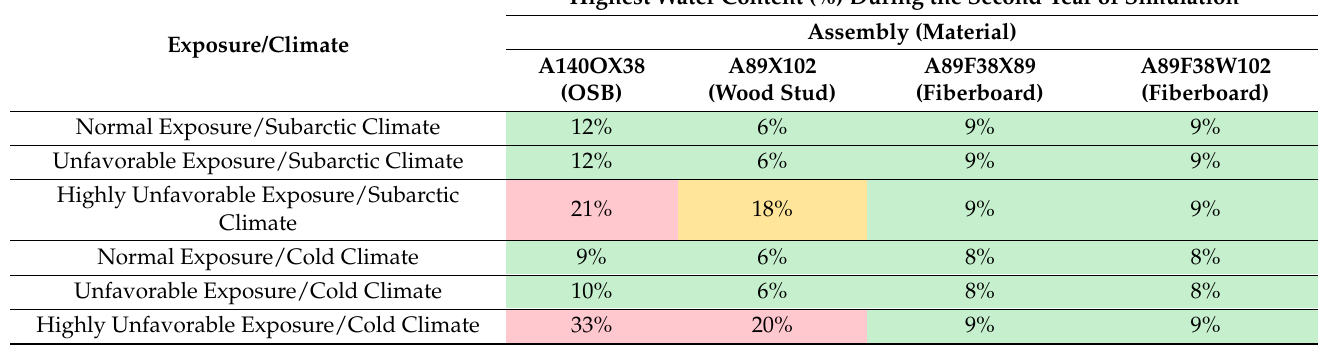
Table 6. The highest water contents during the second year of simulation as a function of the conditions and climate of the wall